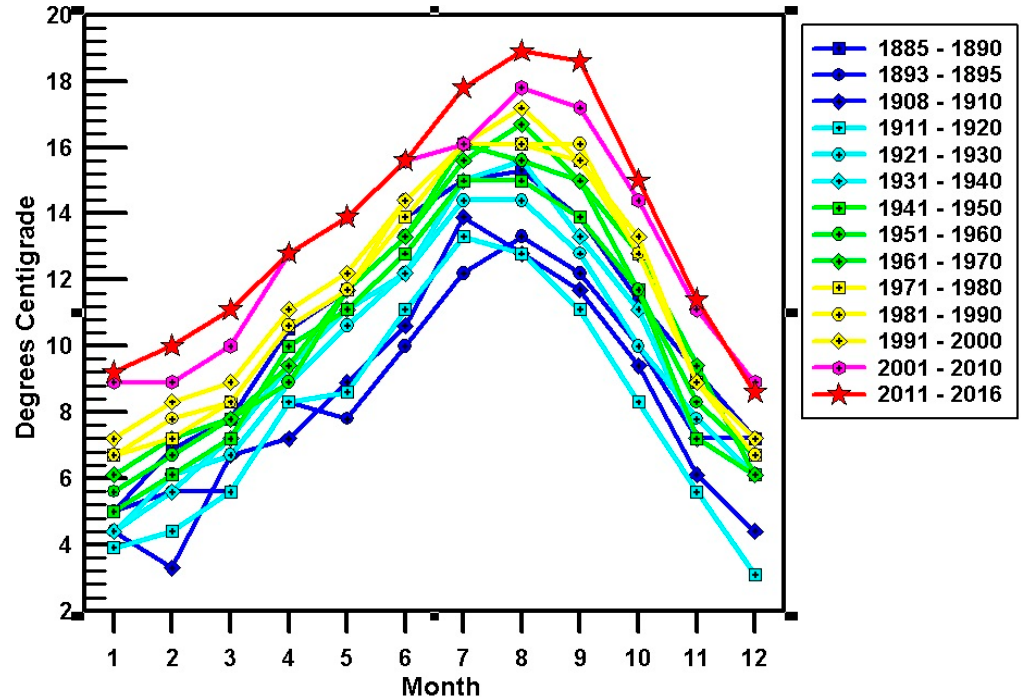
Figure 3. Median nighttime temperatures by decade and month, 1885–2016.